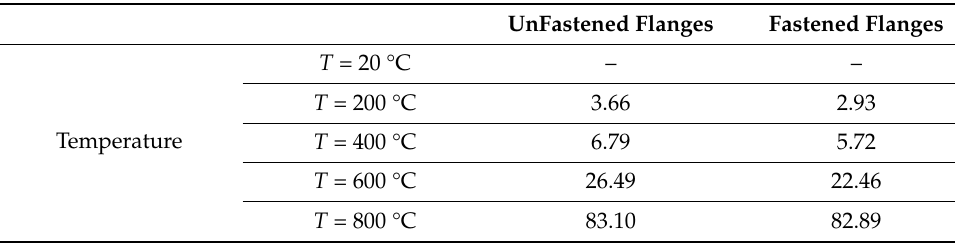
Table 6. Average strength reduction percentage (%) of investigated sections at elevated temperature against ambient temperature ( T = 20 °C).